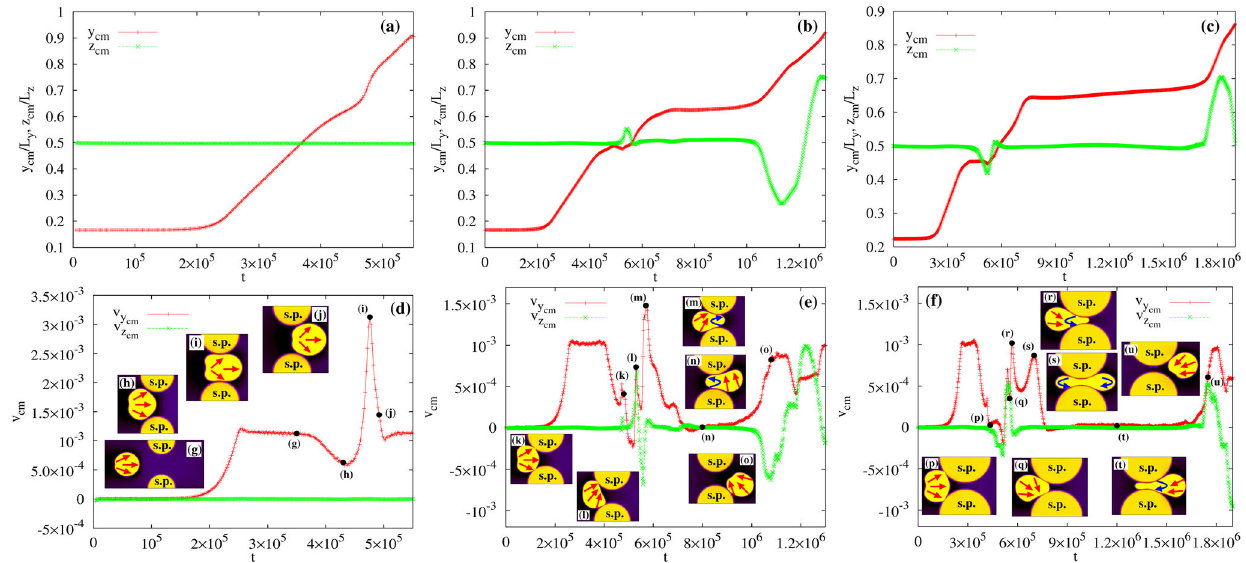
Fig. 3 | Center of mass position and speed of the active drop for different pore sizes. Top row: Time evolution of the y (red, pluses) and z (green, crosses) com- ponents of the center of mass of the active droplet for λ ≃ 0.8 ( a ), λ ≃ 0.5 ( b ), and λ ≃ 0.2 ( c ). Bottom row: Time evolution of y (red, pluses) and z (green, crosses) components of the speed of the center of mass for λ ≃ 0.8 ( d ), λ ≃ 0.5 ( e ), and λ ≃ 0.2( f ).Blackdotsindicatethepositionoftheinsetsrepresentinginstantaneous con fi gurations observed during the crossing. Red arrows show the direction ofthe splaydeformationswhileblueonesthatofthebending.Also, “ s.p. ” standsforsolid pillars. If λ ≃ 0.8, the droplet proceeds almost unaltered along its unidirectional trajectory,progressivelydecreasingthespeedattheentranceofthepore( g , h )and rapidly augmenting it in the middle ( i , j ), where shape deformations are larger. If λ ≃ 0.5,thespeeddiminishesattheentranceoftheconstriction( k )andthenrapidly